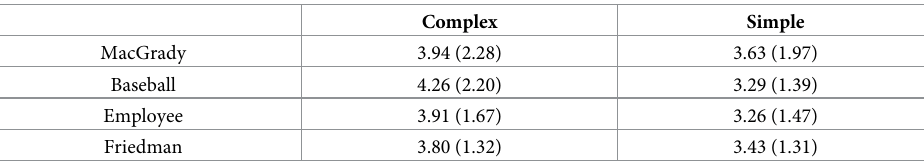
Table 3. Complexity